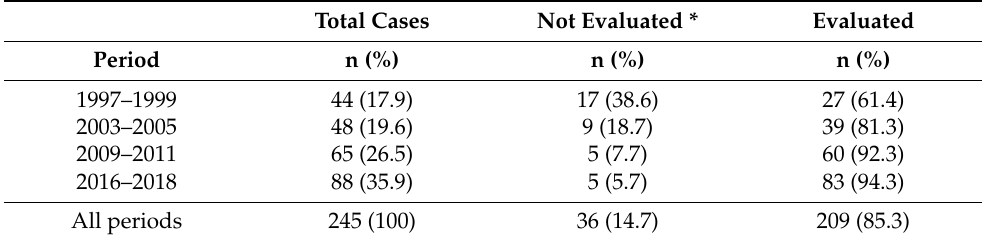
Table 2. Cases evaluated or not for p16 expression, according to calendar period.